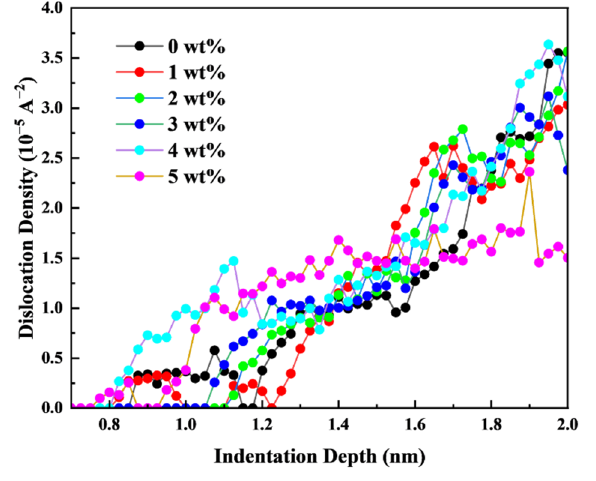
Figure 11. Plotting of the Dislocation density of five different Zr content of Nb-Zr alloys at 1470 K.